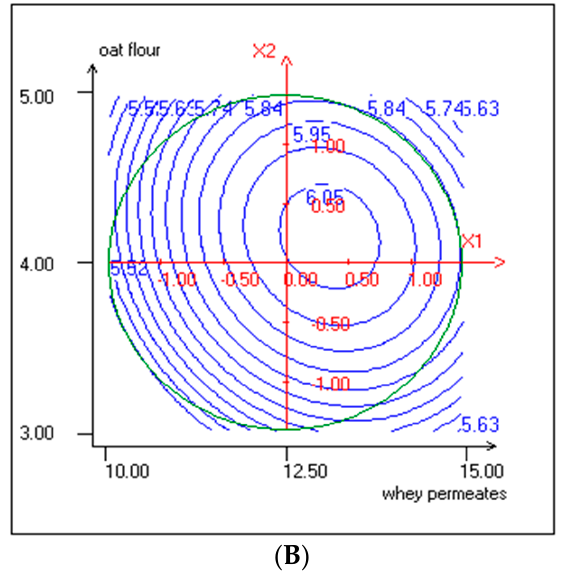
Figure 1. ( A ) Response surface and contour plots representing the effect of WP and OF on lactic acid bacteria cell counts (X1: WP; X2: OF). ( B ) Response surface and contour plots representing the effect of WP and OF on yeast cell counts (X1: WP; X2: OF). Lactic acid bacteria and yeast cell densities varied from 7.85 ± 0.08 to 9.29 ± 0.09 and 5.47 ± 0.27 to 6.05 ± 0.29 log CFU/mL, respectively (Table 2). The enrichment of carob